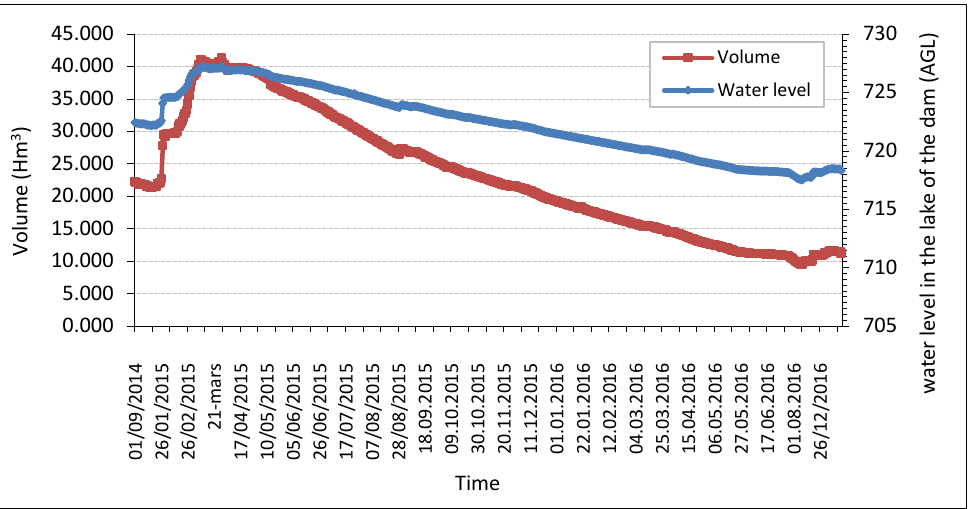
Figure 38. Variation over the time of the couple of water level in the lake and the filling volume at Hammam Grouz dam during the period from 2014 to